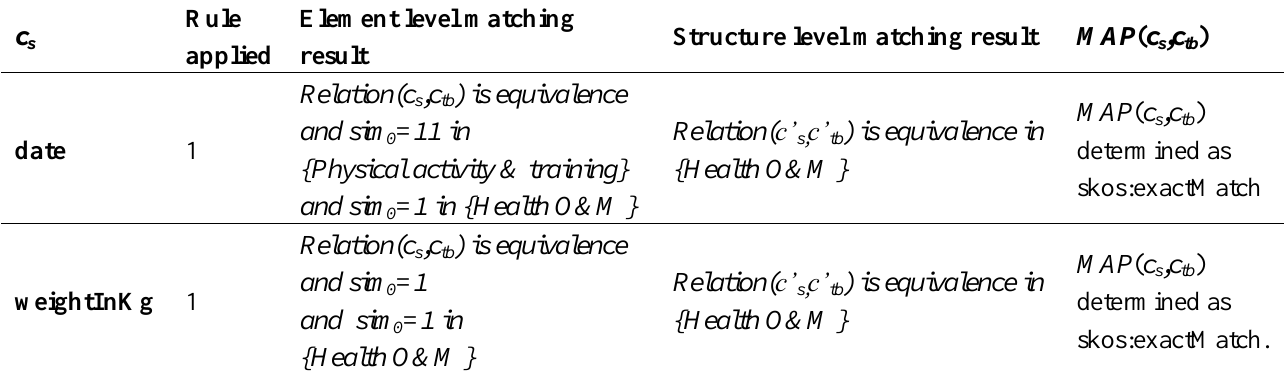
Table 12. Mappings determined after rule